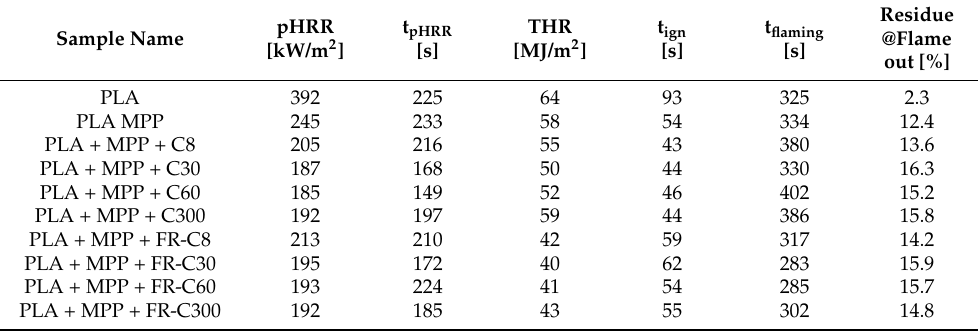
Figure 6. Heat release rate curves of the composites with ( a ) untreated cellulose additive; ( b ) FR-treated cellulose additives. Table 9. Average mass loss calorimetric results of the PLA composite samples with different cellulose fibre length.